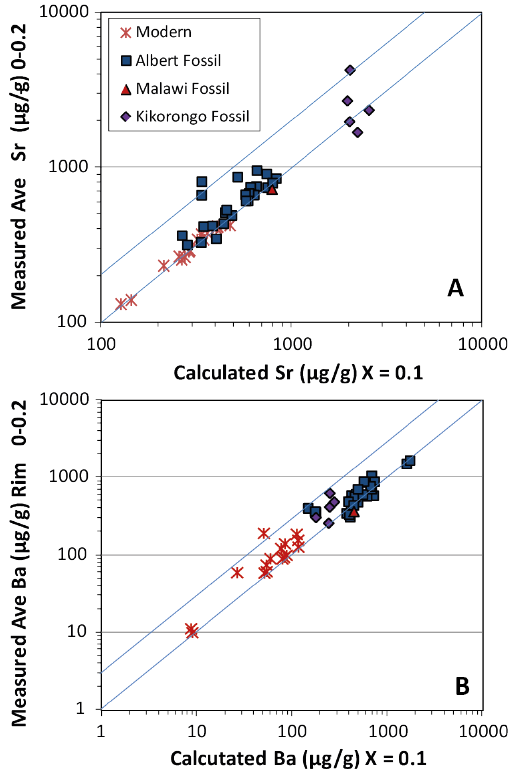
Fig. 3. Comparison of (a) Sr and (b) Ba concentrations measured at the outside enamel rim of single modern and fossil tooth specimens with values expected there based on linear regression analyzes. Val- ues above or below the 1 : 1 line suggest secondary addition or re- moval, respectively, of Ba and Sr. For details see Sect.